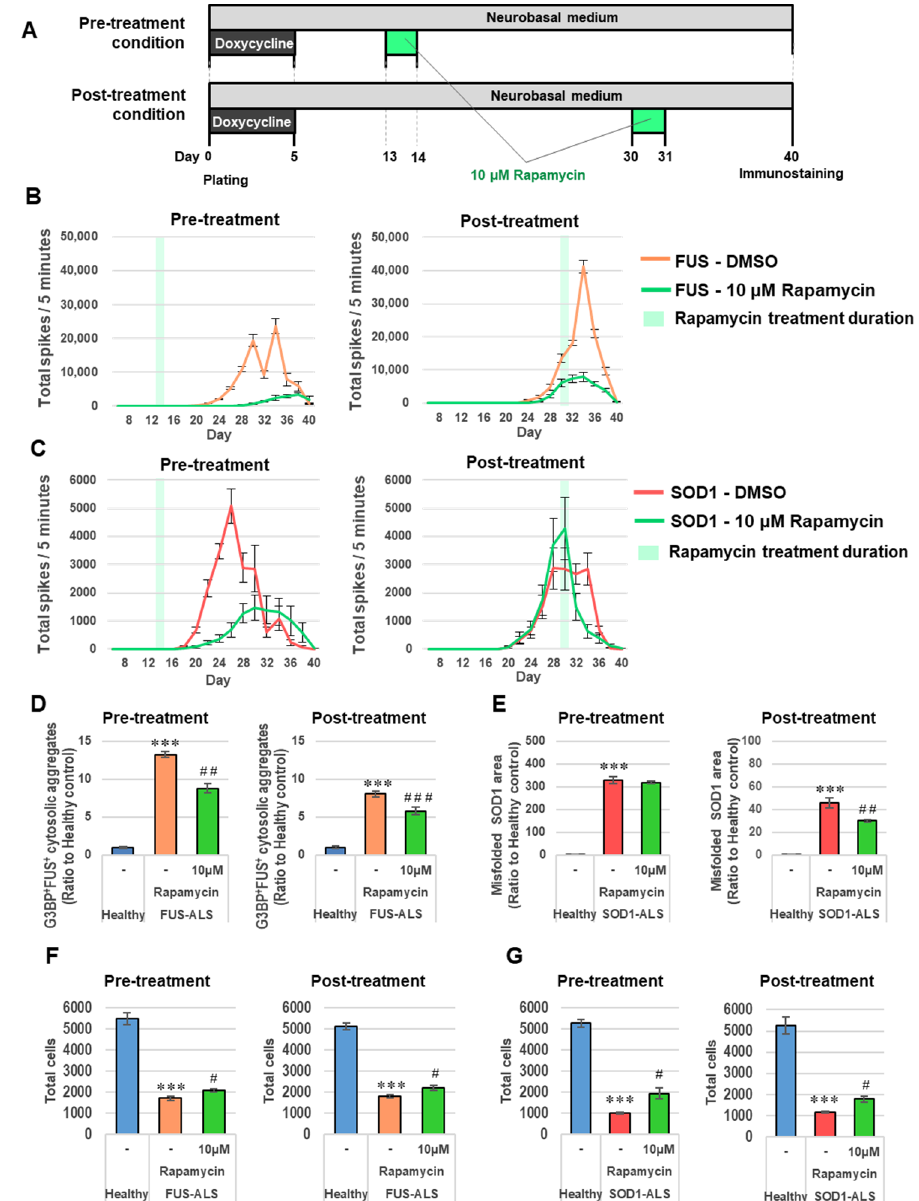
Figure 5. E ff ect of rapamycin on hyperexcitability in ALS neurons. ( A ) Overview of the scoring system for the e ff ect of rapamycin on hyperexcitability in ALS-neurons. The number of spikes in ( B ) FUS- ALS; and ( C ) SOD1- ALS following pre-and post-treatment of rapamycin were evaluated from day 6 to 40. Each value represents the mean ± SEM ( n = 4). The e ff ect of rapamycin on ( D ) FUS stress granule formation in FUS- ALS; and ( E ) the accumulation of misfolded SOD1 in SOD1- ALS were evaluated on day 40. Each value was normalized to that of the healthy control ( n = 4, mean ± SEM). The e ff ect of rapamycin on the cell counts of ( F ) FUS-ALS; and ( G ) SOD1-ALS were evaluated on day 40. Each value represents mean ± SEM ( n = 4). ***: p < 0.001 vs. healthy control ( t -test); #: p < 0.05; ##: p < 0.01; ###: p < 0.001 vs. vehicle control (Dunne tt test).